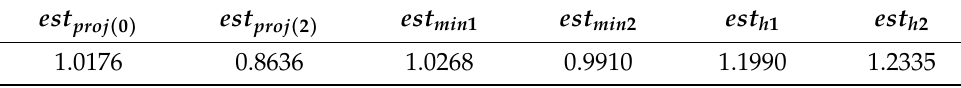
Table 2. Estimating x T A − 2 x = 1.2072, where A = KMS , x = e 1000 + 1/4 e 120